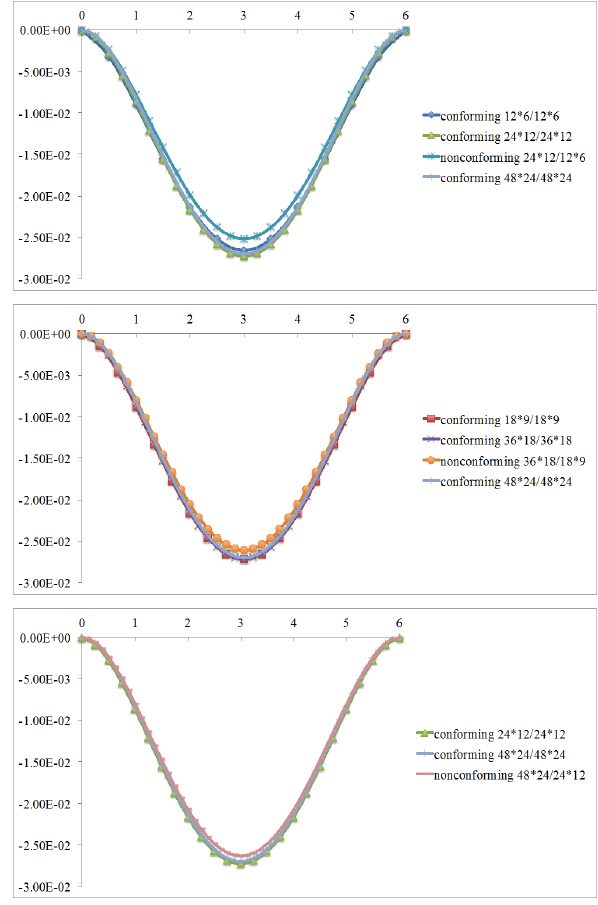
Figure 11: Transverse displacement u 3 distribution for a double- layer shell with Adini-Clough elements using conforming and non- conforming mesh configurations.